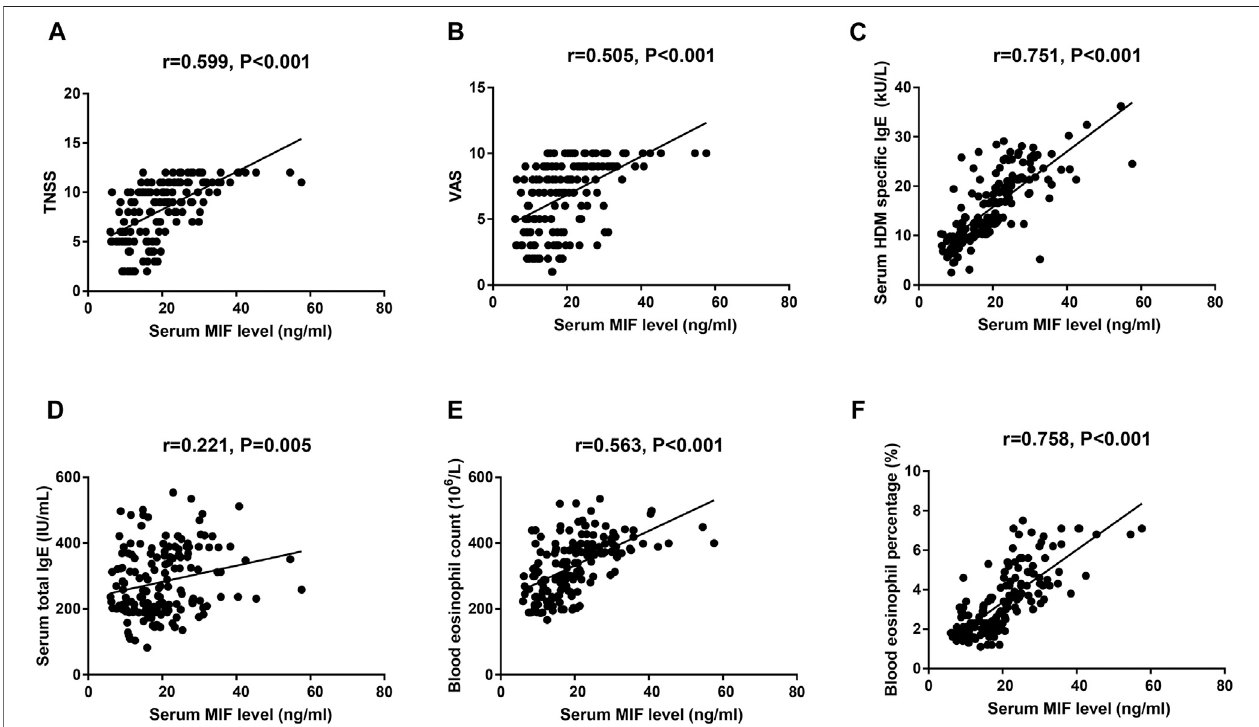
FIGURE 2 | Spearman ’ s correlation analysis of association among serum MIF levels, TNSS (A) , VAS (B) , serum HDM – speci fi c IgE (C) , total IgE (D) , blood eosinophil count (E) , and percentage (F) in HDM-induced AR patients. MIF, macrophage migration inhibitory factor; HDM, house dust mite; AR, allergic rhinitis; TNSS, total nasal symptom score; VAS, visual analogue scale.